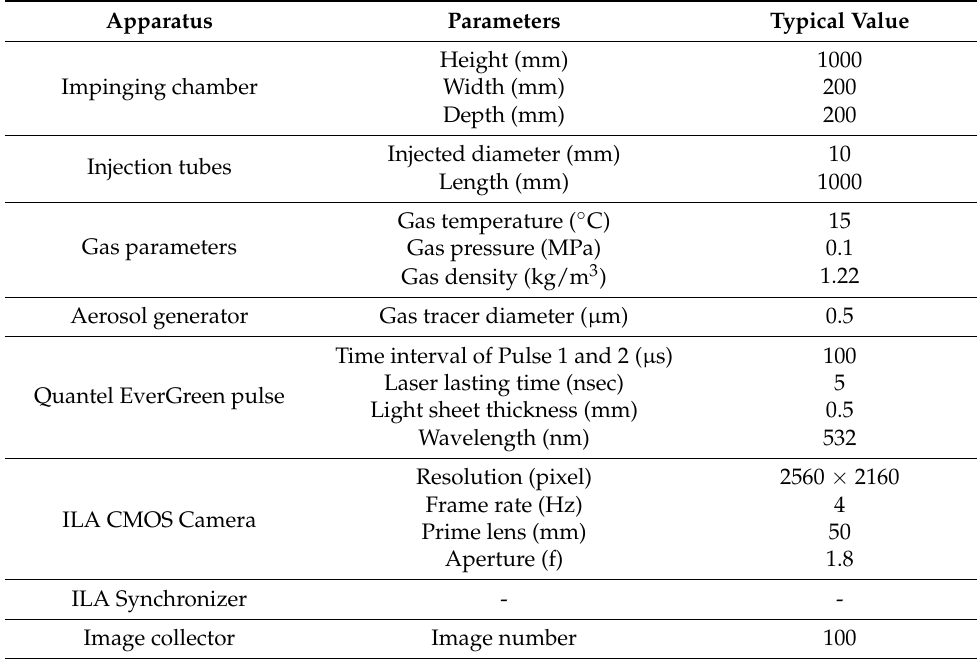
Figure 1. ( a ) Schematic diagram of the experimental setup and ( b ) sketch map of the captured horizontal cross section of corner-injected flow. Table 1. The experimental setup